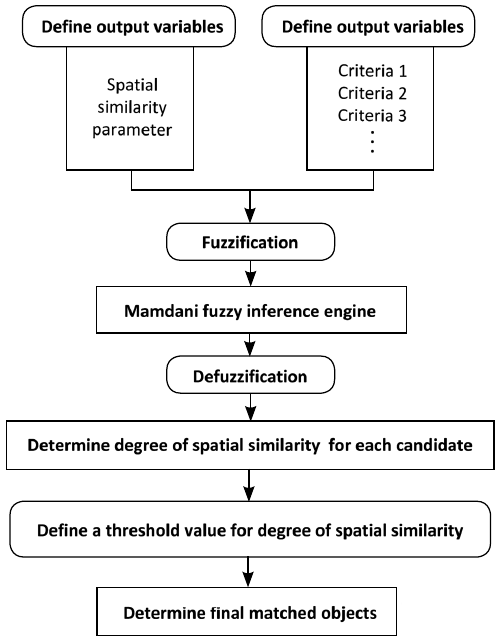
Fig. 10. General Framework of detecting correspond